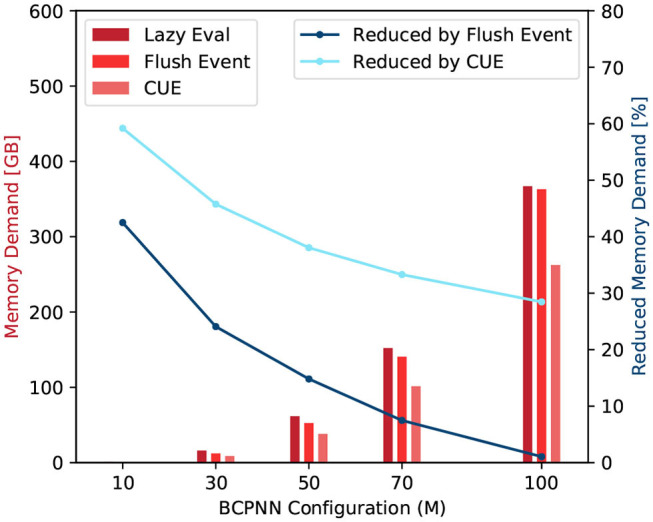
Memory access demand comparison (red) and memory demand reduction by the flushing event method and the CUE method (blue).